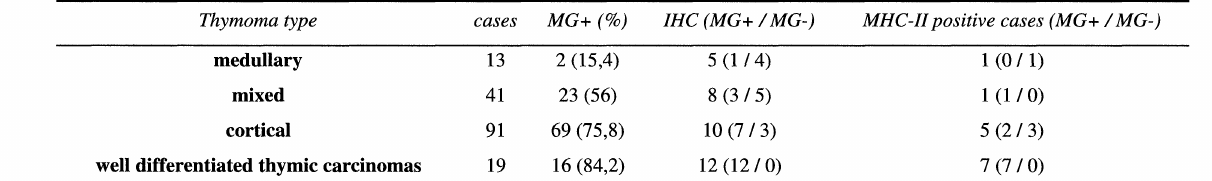
TABLE Histological subtypes and prevalence of myasthenia gravis in 164 thymoma cases and results of immunohistochemical analysis of MHC class II isotypes in 35 cases with available frozen material Thymoma